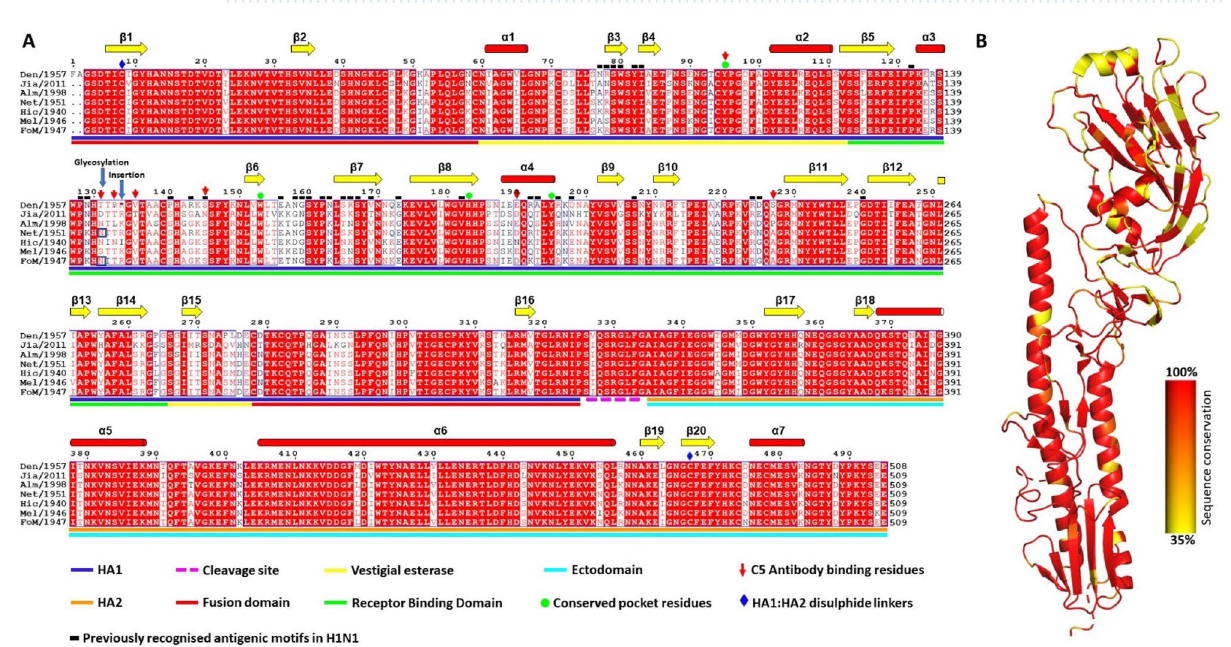
Figure 3. Sequence conservation among hemagglutinins (HAs) of seven influenza virus A (IVA) strains. ( A ) Multiple sequence alignment of HA from seven IVA strains. The secondary structural elements of the A/ Denver/57 strain (PDB ID: 6ML8) are shown above the alignment. Conserved residues are highlighted in red. Residues of the HA1 segment and HA2 segment are shown with a blue and orange line below the alignment, respectively. The purple dashed line shows the cleavage site between the HA1 and HA2 segments. The second line below the alignment indicates the HA domains: red for the fusion domain, yellow for the vestigial esterase domain, green for the receptor binding domain, and cyan for the ectodomain. Putative sialic acid binding pocket residues are shown with green circles. Cysteines responsible for disulfide bonds between HA1 and HA2 segments are shown with blue diamonds. C05 binding residues on A/Denver/57 HA are indicated with red down arrows. Previously identified antigenic sites are indicated by black dashes. Multiple sequence alignment was performed using Clustal Omega 27 ; the graphical output was generated by ESpript (https:// espri pt. ibcp. fr/ ESPri pt/ ESPri pt/). ( B ) Structure of the IVA HA proteins coloured by sequence conservation, where red indicates 100% conservation and yellow indicates 35% sequence identity. Conservation was performed using PDB codes 6ML8, 6D8W, 6MYA, 6N41, 6ONA, 6OSR, and 7JPD in ConSurf server 40